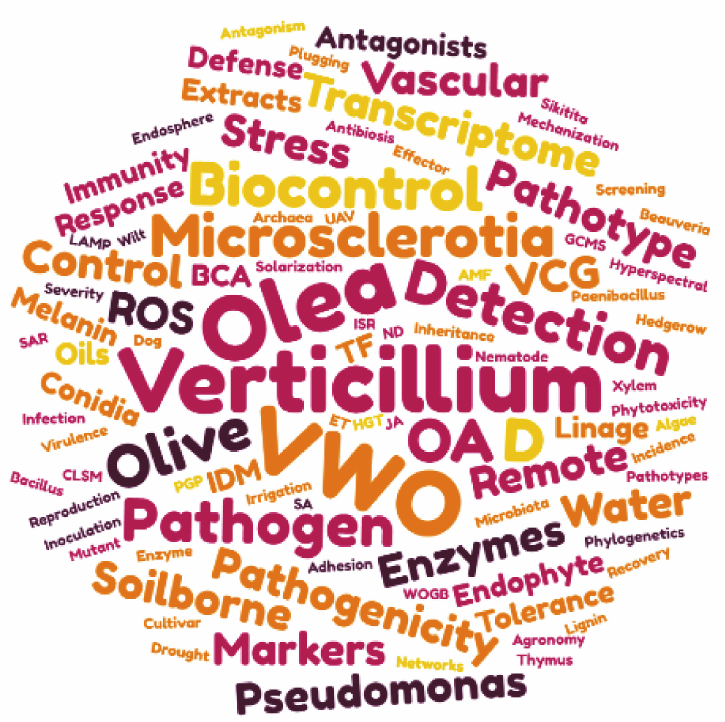
Figure 2. Tag-cloud showing the most relevant keywords cited in the bibliography consulted to produce this review article. The figure was built using a free online word cloud generator [20]. The importance of each tag is visually weighted according to its frequency of use. The acronyms used are defined as follows: Arbuscular Mycorrhizal Fungi (AMF), Biocontrol Agents (BCA), Confocal Laser Scanning Microscopy (CLSM), Defoliating (D), Essential Oils (oils), Ethylene (ET), Gas Chromatography–Mass Spectrometry (GCMS), Horizontal Gene Transfer (HGT), Induced Systemic Resistance (ISR), Integrated Disease Management (IDM), Jasmonic Acid (JA), Loop-Mediated Isothermal Amplification (LAMP), Non-Defoliating (ND), Organic Amendments (OA), Plants Extracts (extracts), Plant Growth Promotion (PGP), Reactive Oxygen Species (ROS), Salicylic Acid (SA), Systemic Acquired Resistance (SAR), Transcription Factor (TF), Unmanned Aerial Vehicle (UAV), Vegetative Compatibility Groups (VCG), Verticillium Wilt of Olive (VWO), Water Disinfestation (Water), World Olive Germplasm Bank